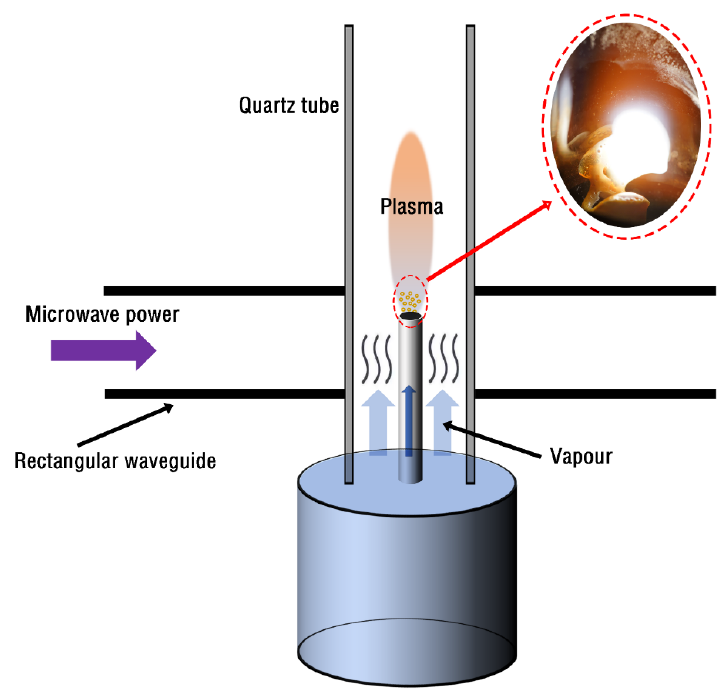
Figure 2. Water vapor plasma is excited by microwave discharge; the left is the actual image of the torch flame on the ceramic tube.